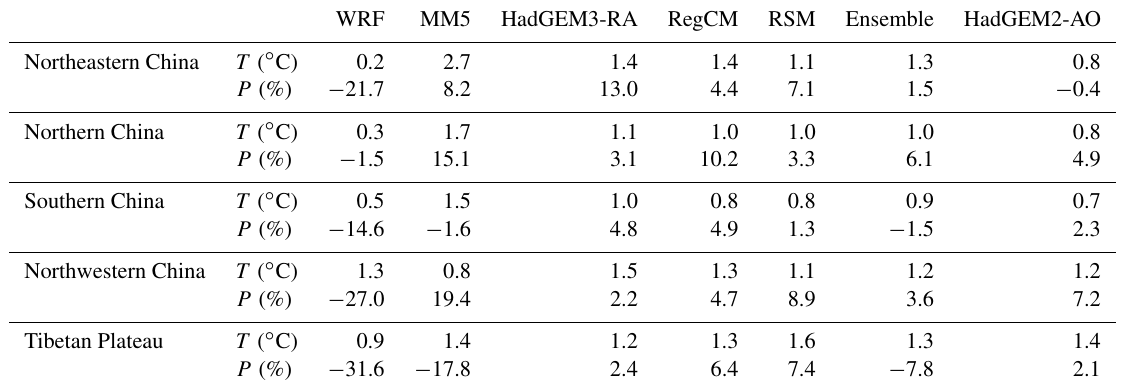
Table 2. The future changes in average temperature ( T ; ◦ C) and precipitation ( P ; %) for the five subregions. The ensemble averages for each statistic are given in the second line. The projections by the forcing GCM are given in the last line. WRF